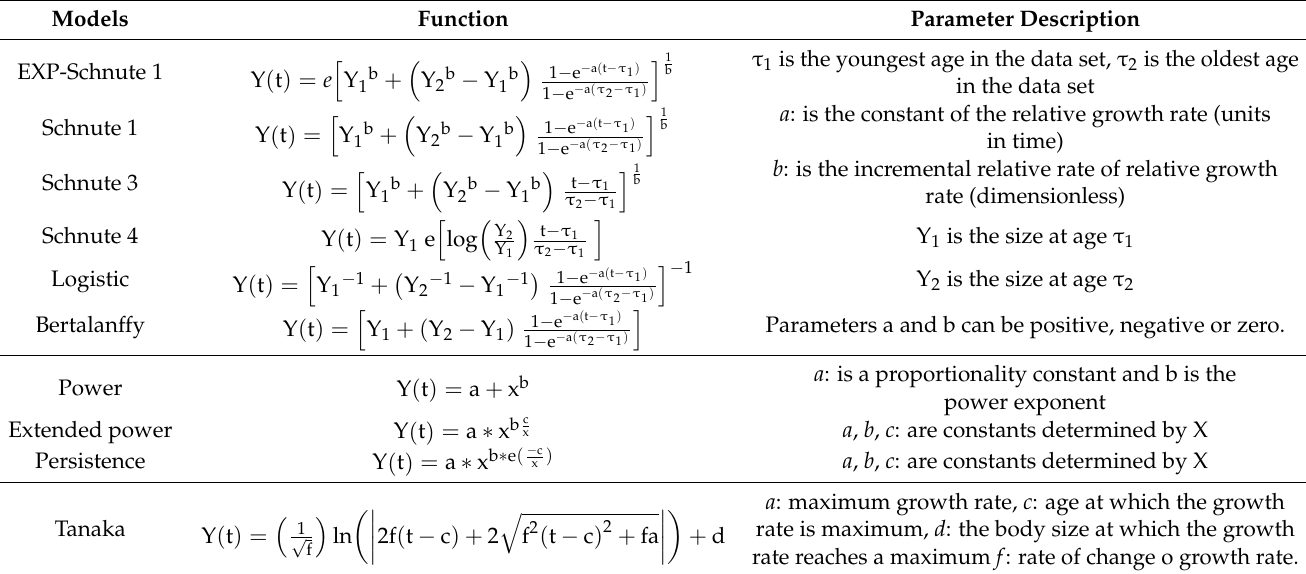
Table 1. The functions and descriptions for each of the ten